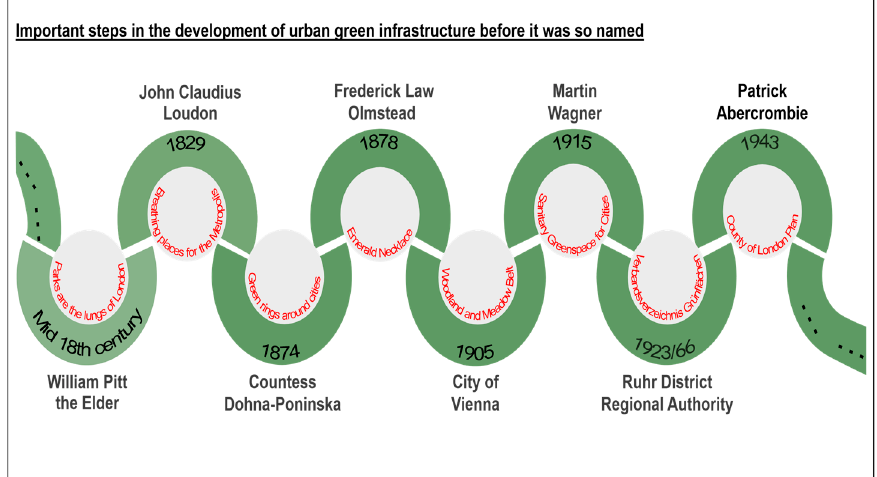
Figure 1. Important steps in the development of urban green infrastructure before it was so named; selected path-breaking projects (authors).